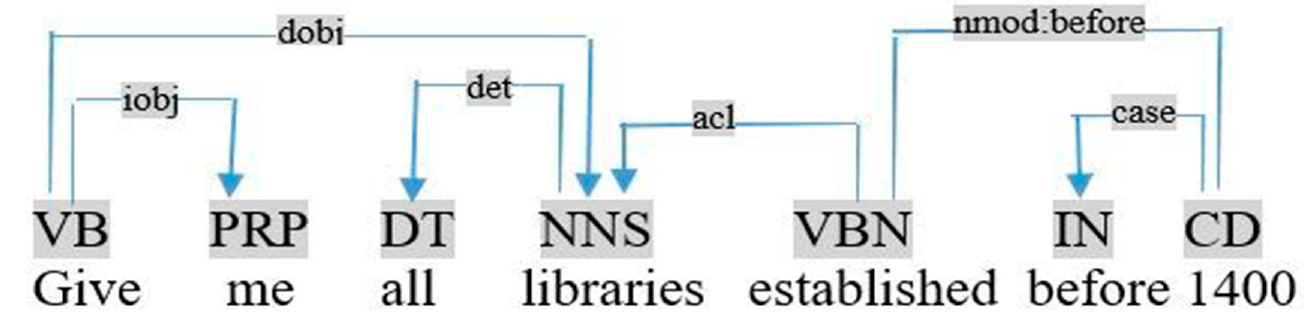
Figure 2. Graph dependency of the query «give me all libraries established before 1400».